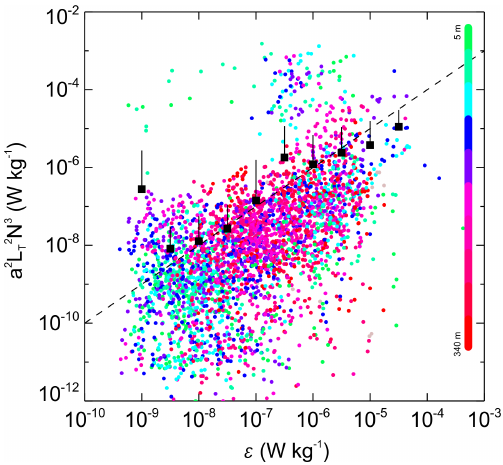
Figure 13. Comparison of dissipation resolved from the L Oz with the direct measure of ε . Averages were calculated in log 10 space for ε and all length-scale-based estimates in that bin were collated. Here the average and average + 1 standard deviation are shown with a circle–line pair and the average in log 10 space is shown as a square. The averages excluded outliers in the surface water as described in the